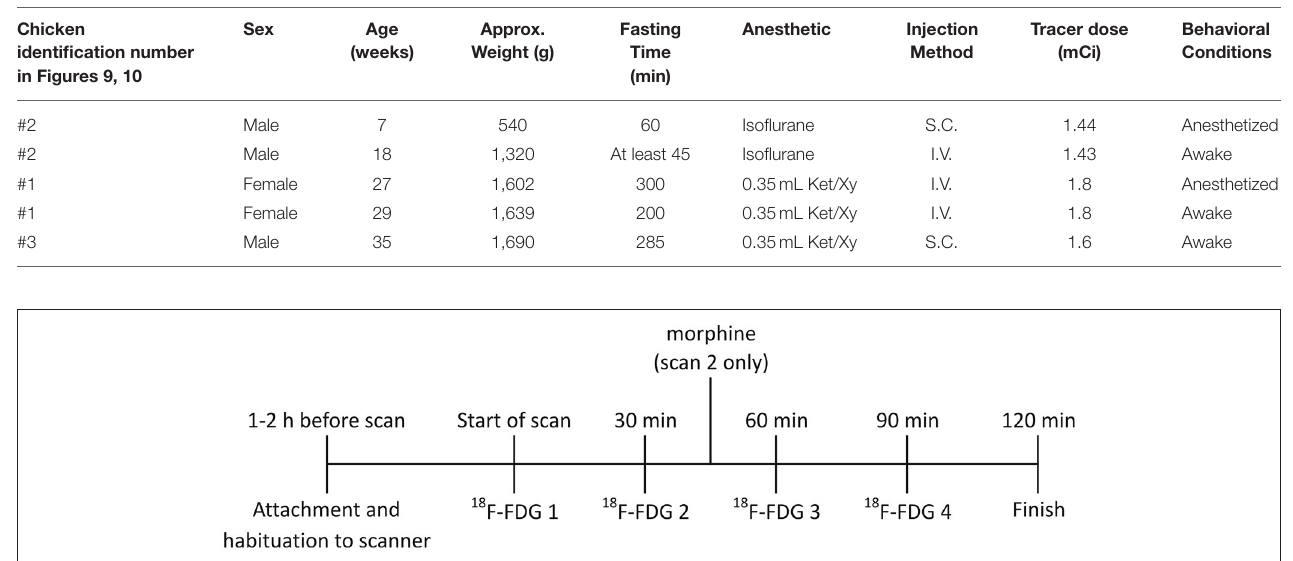
TABLE 1 | Chicken information and imaging combinations for each microPET scan. Chicken identification number